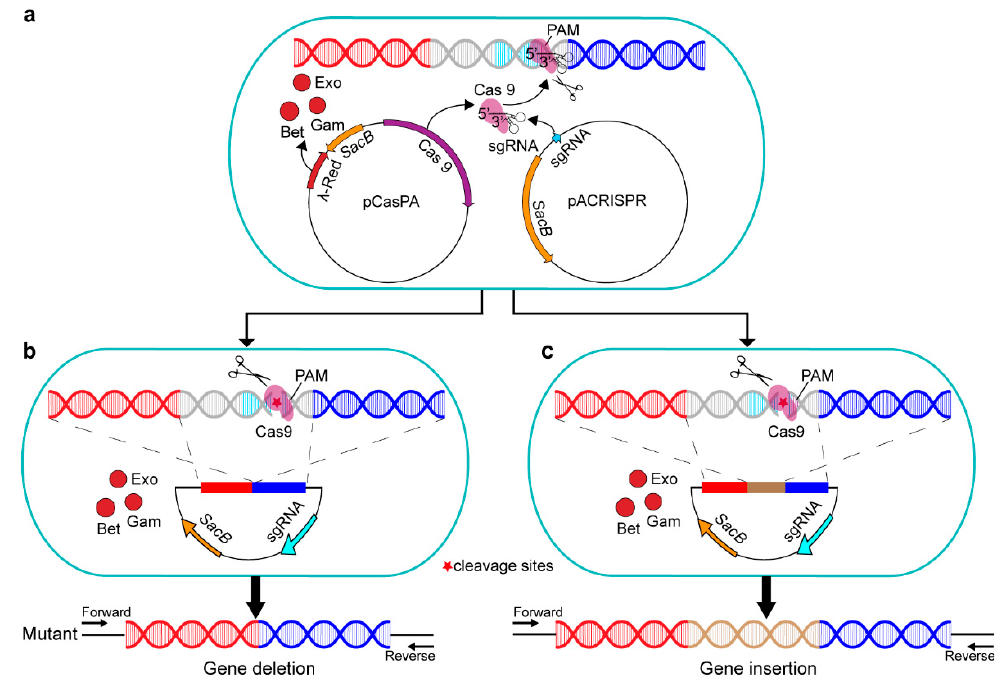
Figure 1. The diagram of the gene − editing approach based on the pCasPA/pACRISPR system in P. fulva . ( a ) The CRISPR − Cas9 system recognizes a 5 ′− NGG − 3 ′ PAM sequence for specific cleavage activity, generating the double − stranded DNA break. ( b ) Homologous recombination − mediated gene deletion and ( c ) gene insertion. Exo, Gam, and Bet represent the phage λ− Red recombination proteins. The asterisk indicates the cleavage site.